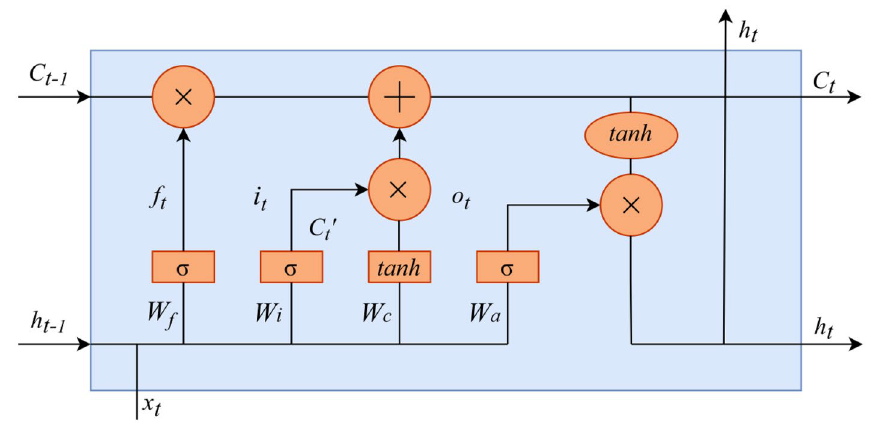
Figure 1. LSTM model structure.